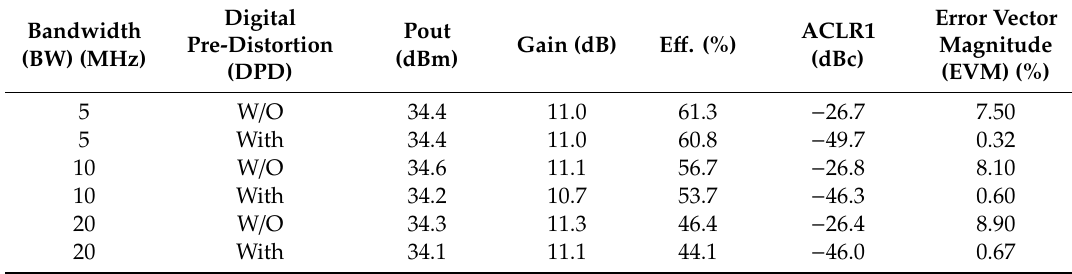
Table 3. Summary of measurement results of the ET system